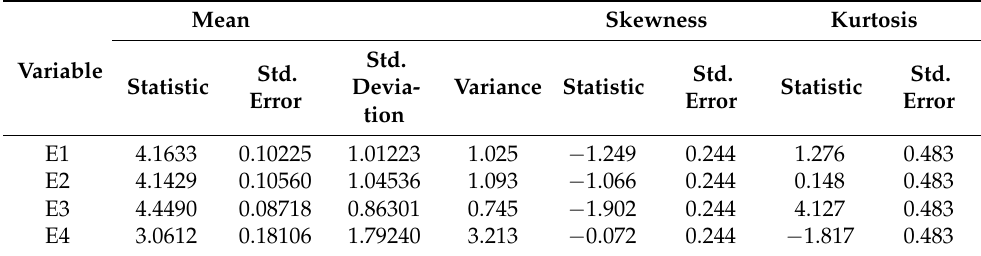
Table 4. Descriptive statistics of effectiveness variables.